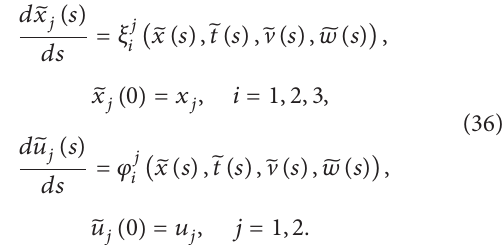
Table 2: Adjoint representation of the approximate symmetries of the KPP equation.